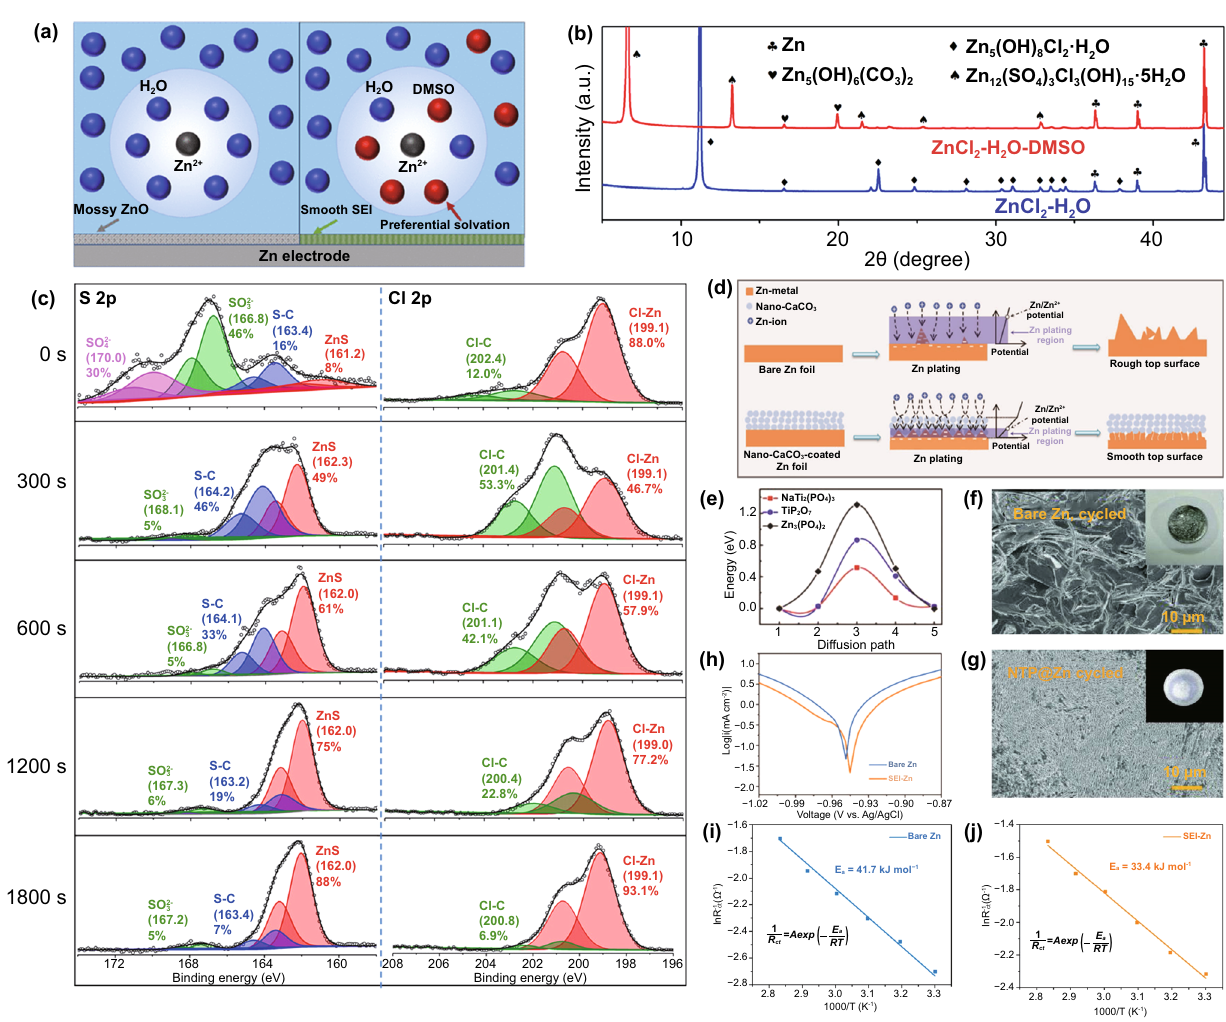
Fig. 9 a Scheme of the Zn 2+ solvation structure and Zn surface passivation in H 2 O and H 2 O-DMSO solvents. b XRD patterns of Zn anodes after plating/stripping cycles in ZnCl 2 -H 2 O-DMSO and ZnCl 2 -H 2 O electrolytes. c XPS characterization of the SEI formed on Zn cycled in